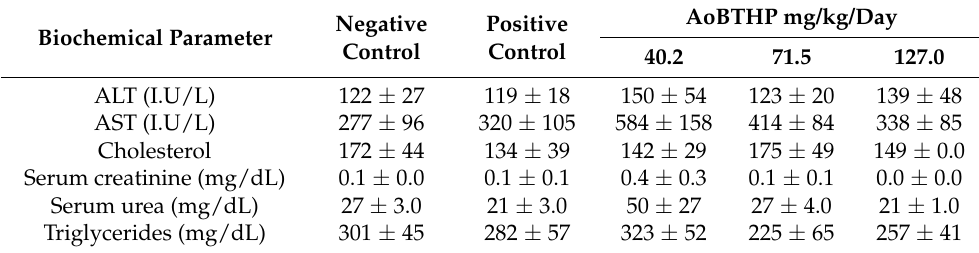
Table 5. Biochemical parameters of sacrificed animals (mean ± SEM).